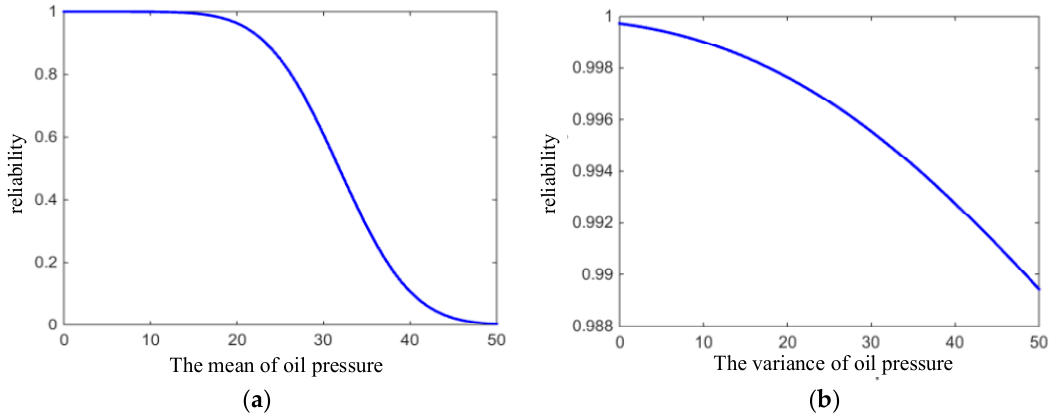
Figure 9. Reliability varying with the ( a ) mean and ( b ) variance of oil pressure.